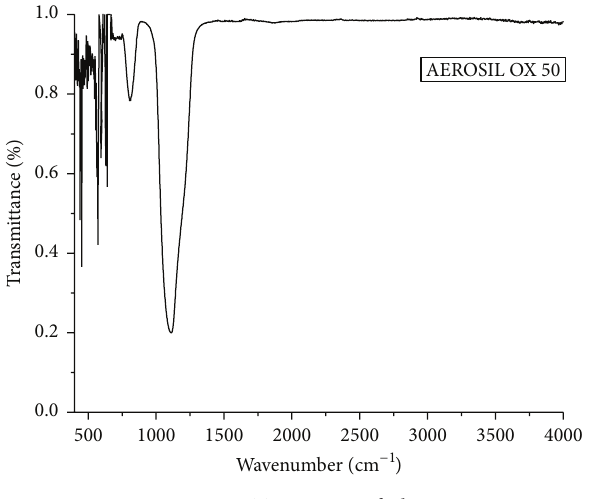
Figure 1: FTIR spectra of silica.